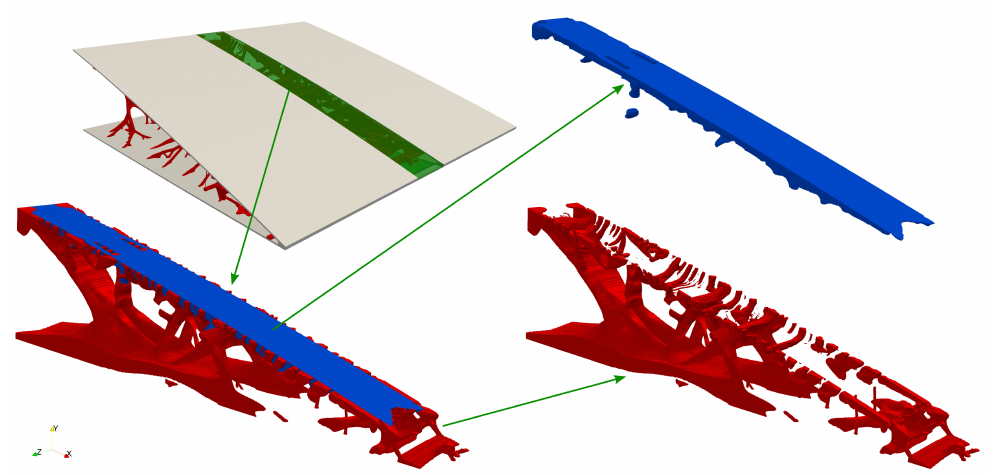
Figure 7. Isolation of actuator portion of the resulting topology from the density approach with two design domains. The field is realized with a threshold value of 0.5. Notice how a very complex structural design formed around the actuating